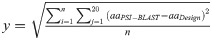
Design native sequence recovery and mutation profile variability comparisons to PSI-BLAST profiles.(A) Comparison of total native sequence recovery of relaxed and unminimized RECON MSD and SSD designs to PSI-BLAST sequence profiles generated using the native sequence. For this figure and all subsequent boxplots, shaded regions of each box plot denote values within the first and third quartiles (interquartile range, or IQR), with the median indicated as a solid line and whiskers representing values ± 1.5 × IQR. Outliers are represented as dots. Asterisks indicate the significance of difference of means of each design in comparison to the PSI-BLAST profile, with a z-test p-value < 0.01 represented by one asterisk, and a p-value < 0.00001 by three asterisks. The p-value provided in this figure and all subsequent figures represents a two-sided, 95% confidence interval. (B) Mutation frequency root mean square deviations of designs in comparison to a PSI-BLAST profile. The y-axis values represent the root mean square deviation (RMSD) of mutation profiles for each designed residue in relation to a PSI-BLAST profile, represented as:y=∑i=1n∑j=120(aaPSI-BLAST-aaDesign)2n where aaj represents the frequency of an amino acid observed at position i for each of all twenty amino acids (j), and y is the sum of all i differences for all amino acids within a protein of length n residues. A y-value of 0 would indicate that the design profile is identical to the PSI-BLAST profile, and an increase in y-value indicates the root mean square deviation of the sequence profile for each residue is more dissimilar to a PSI-BLAST profile.